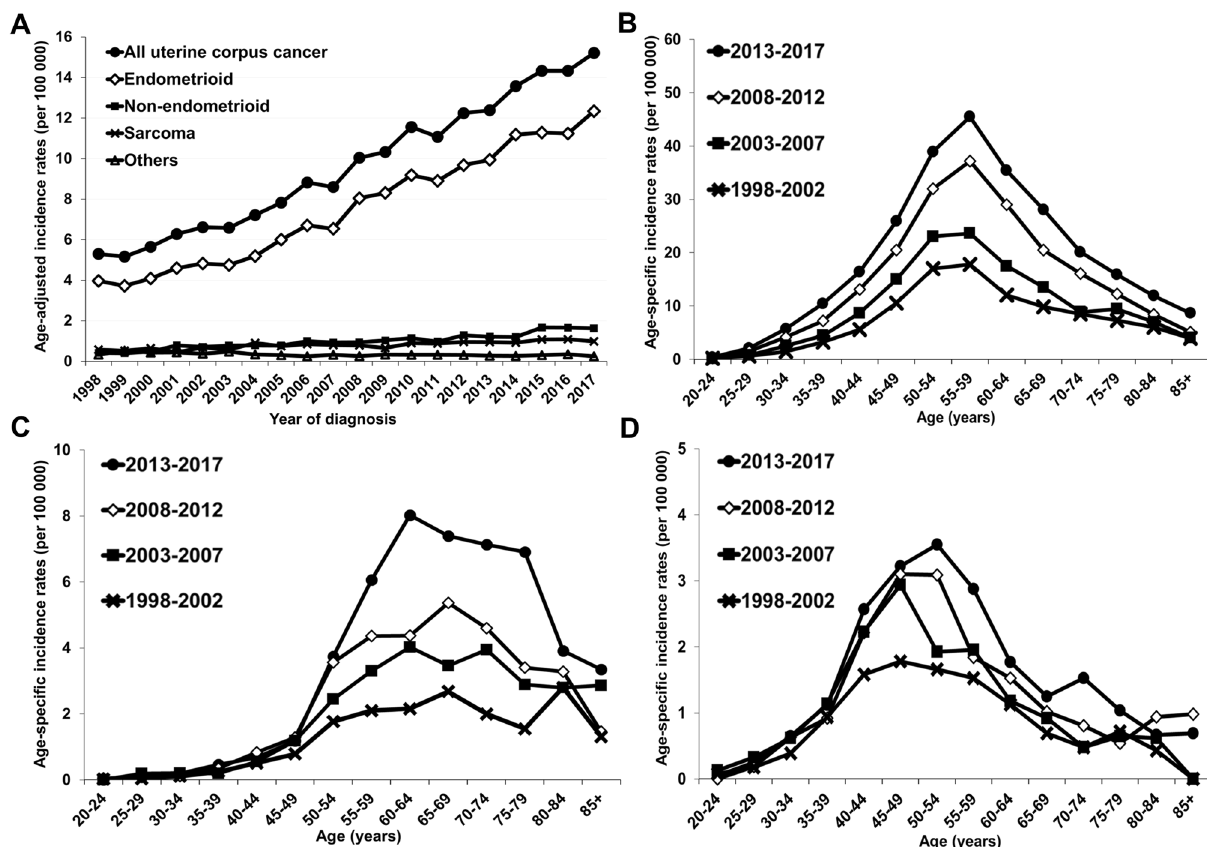
Figure 1. Trends in the incidences of uterine corpus cancer in Taiwan during 1998–2017. ( A ) Age-adjusted incidence of uterine corpus cancers, stratified by histologic type. Age-specific incidence of ( B ) endometrioid carcinoma, ( C ) nonendometrioid carcinoma, and ( D ) uterine sarcoma, grouped by calendar